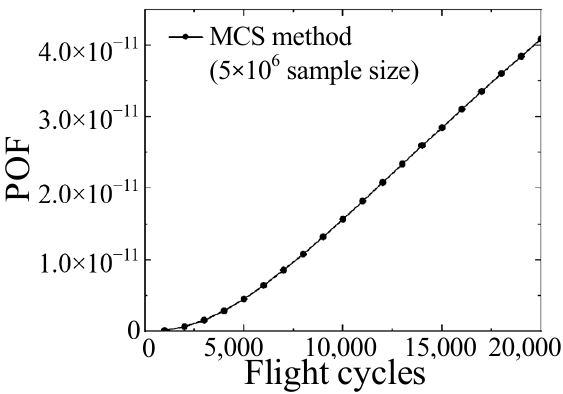
Figure 13. Convergence result of MCS with 5 × 10 6 sample size.